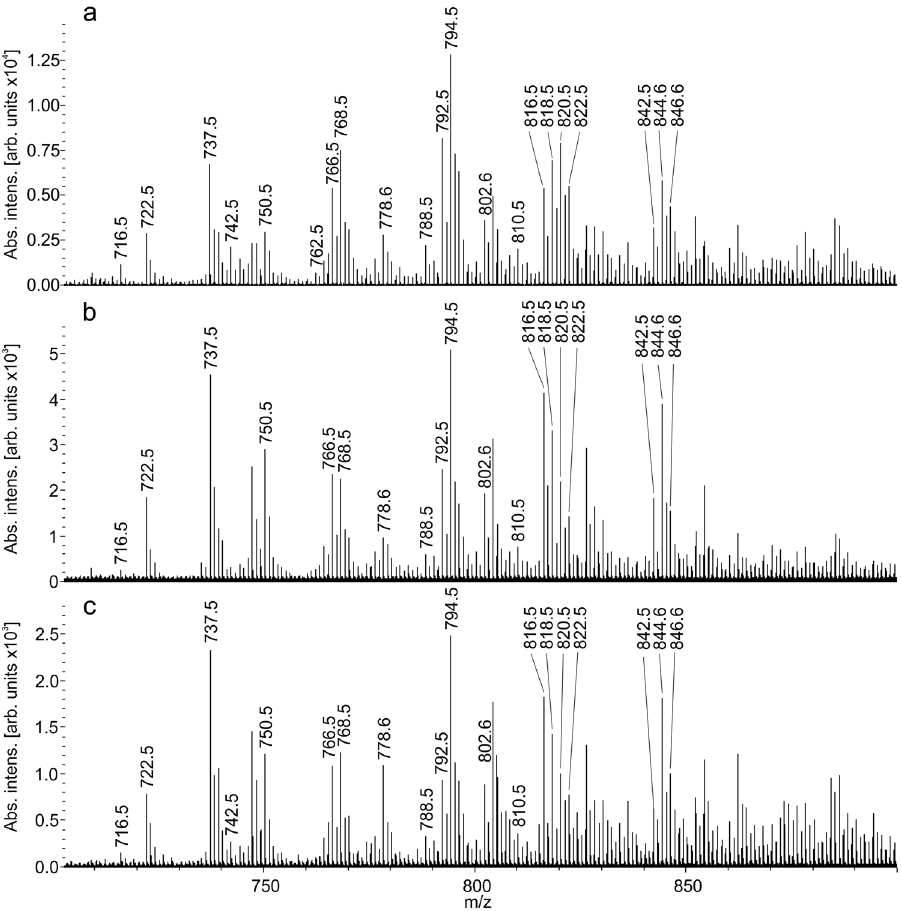
Figure 4. Negative-ion tissue spray mass spectra of ( a ) eutopic endometrium; ( b ) endometriotic ovarian cyst; ( c ) pelvic